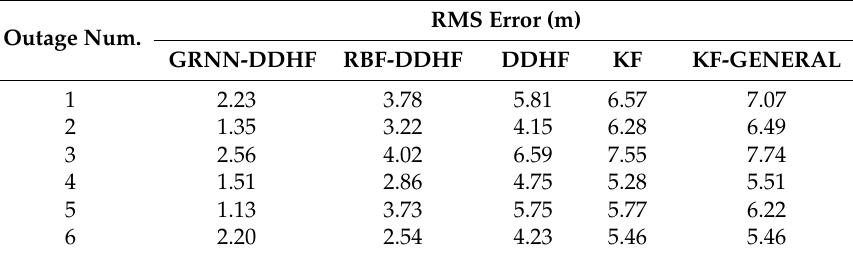
Table 7. RMS position errors during GPS outages for Trajectory 2.